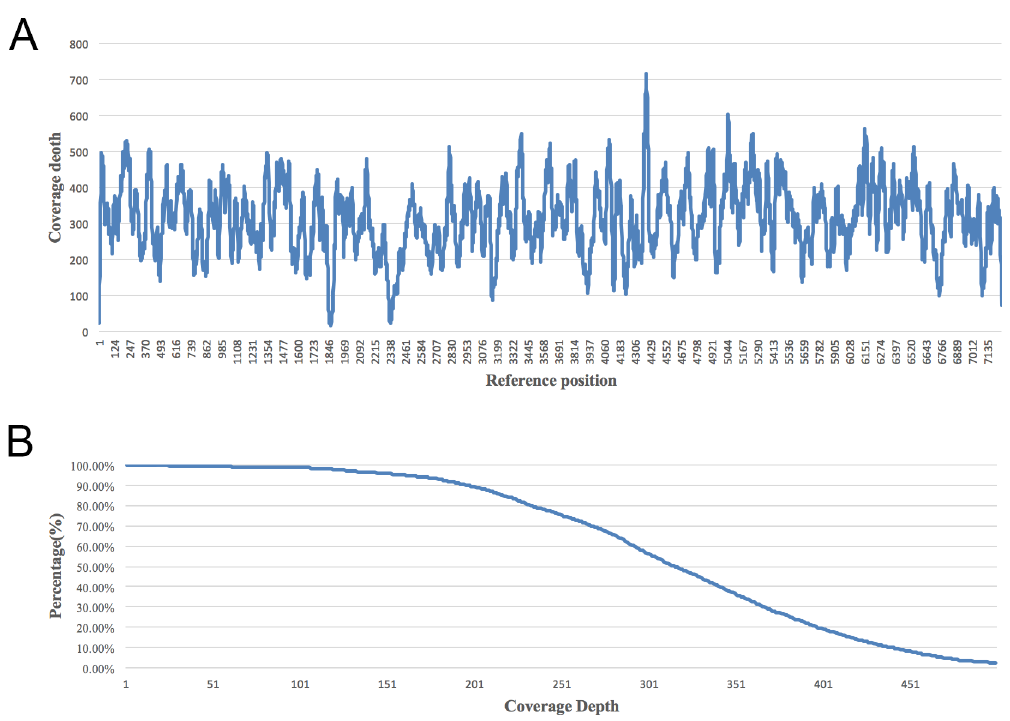
Fig 2. Coverage depth distribution. (A) Coveragedepth for each base on M13 reference. The averagecoverage depth is 316x ± 96x.(B) Coveragerate as a function of coveragedepth.